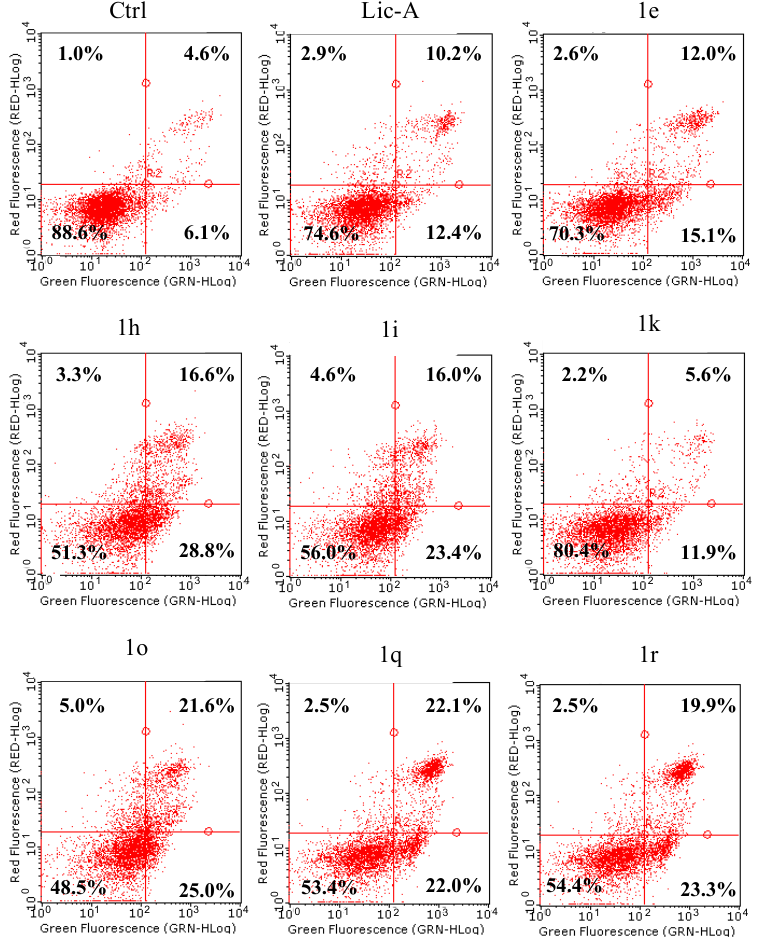
Figure 6. Annexin V and Propidium staining. Cytofluorimetric analysis of annexin V-FITC- and PI-stained cells after 16h treatment with compounds at IC 50 concentrations. At least 5000 cells per sample were analyzed, and quadrant analysis was performed. Left quadrant corresponds to the double negative cells; lower right to the Annexin V-positive and PI-negative cells (early apoptotic); upper right to the double-positive cells (late apoptotic/necrotic); and upper left to the PI-positive and Annexin V-negative cells (necrotic).